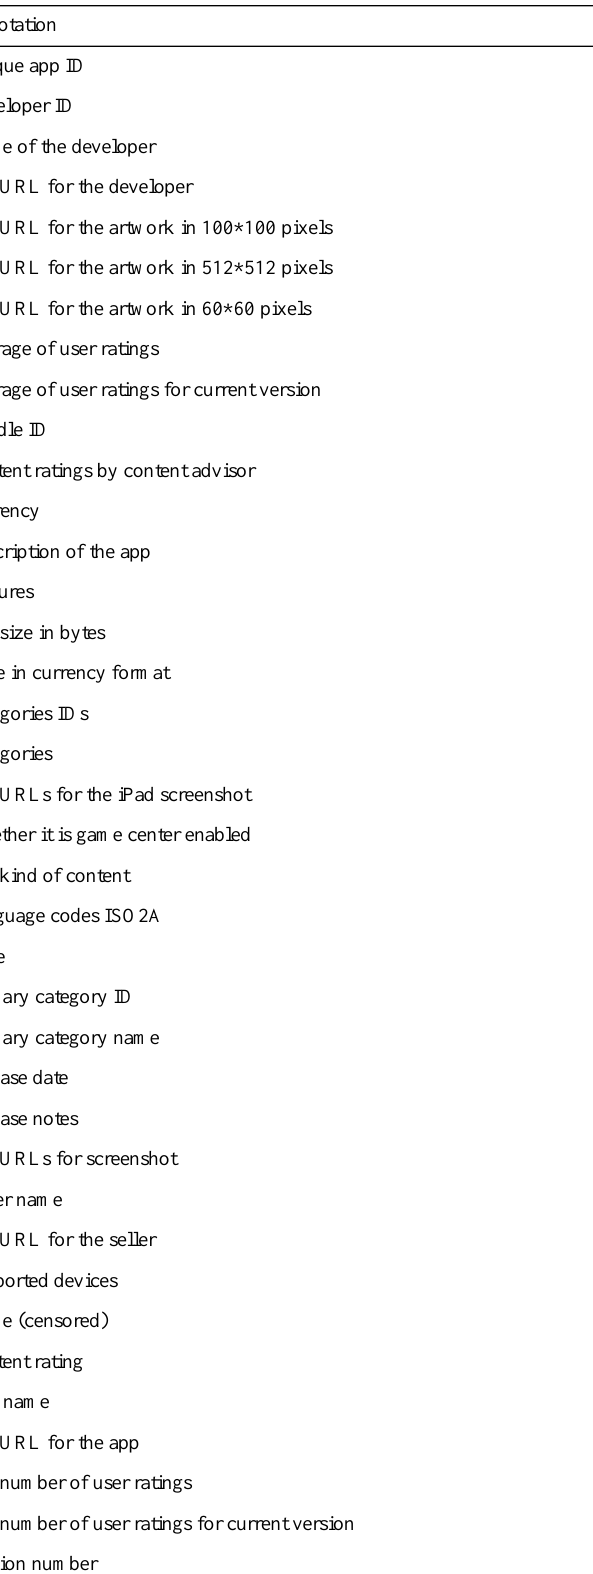
Table 1. The list of 39 features for each app in the AppStore.